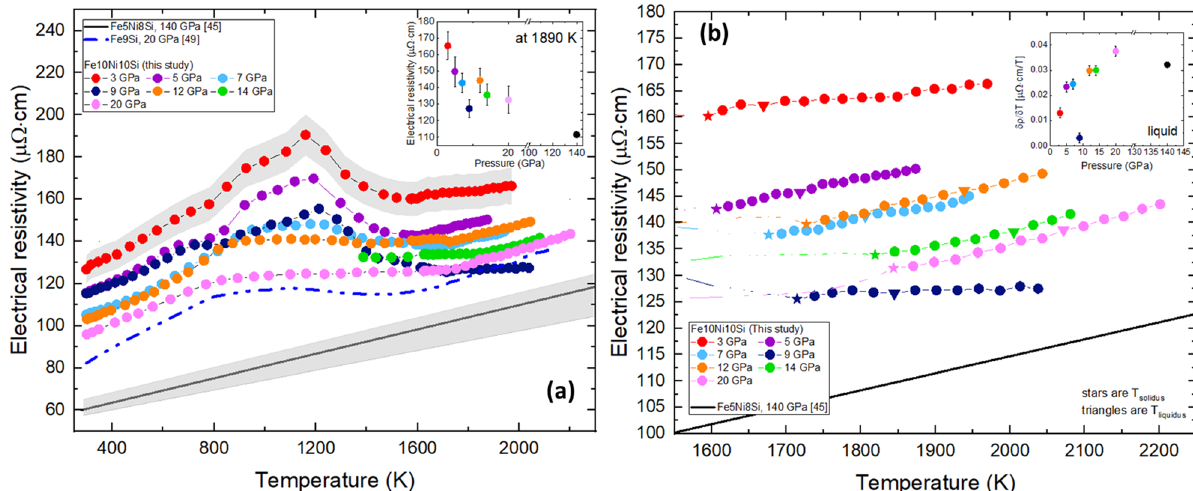
Figure 2. ( a ) Electrical resistivity of Fe10Ni10Si from 3 to 20 GPa as a function of T . The error bar in ρ is 4.4 µΩcm at low T and 8.5 µΩcm at high T . Results are compared to Fe8.5Si at 20 GPa 49 and Fe5Ni8Si at 140 GPa 45 . Grey bands are shown as representative errors bars. The inset plot shows ρ from this study and Zhang et al. 45 at 1890 K as a function of P . ( b ) Electrical resistivity in the liquid state, including the partial melting region in runs where liquid measurements are scarce. The star symbols represent T solidus and the triangles represent T liquidus in each data set. The inset plot shows the ρ slope in the liquid as a function of P .